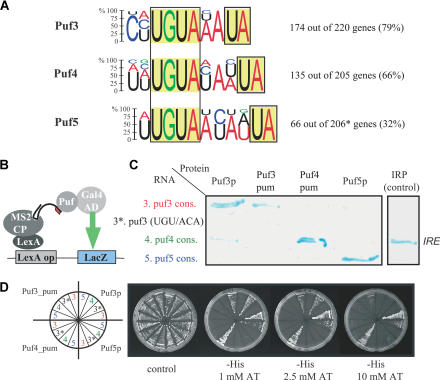
Sequence Motifs Interacting with Puf Proteins(A) Consensus motifs detected within 3′-UTR sequences of Puf3p, Puf4p, and Puf5p target mRNAs. Height of the letters specifies the probability of appearing at the position in the motif. Letters with less than 10% appearance were omitted. Fraction of genes bearing a motif in the 3′-UTR sequence is indicated to the right. Y-helicase proteins are nearly identical in sequence and were excluded from this analysis.(B) Scheme of three-hybrid assay for monitoring RNA–protein interactions in vivo (Bernstein et al. 2002).(C) β-Galactosidase activity for three-hybrid assay. Proteins assayed are indicated on top, RNAs to the left. Abbreviations: pum, pum-HD; cons., consensus motif; UGU/AGA, UGU in consensus sequence mutated to AGA.(D) Activation of HIS3 reporter gene and resistance to 3-aminotriazole (3-AT), a competitive inhibitor of the HIS3 gene product, in a three-hybrid assay (Bernstein et al. 2002).